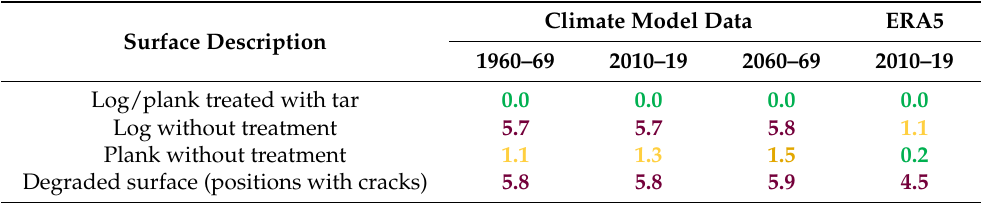
Table 6. Average values of annually maximum mold indices by taking into account all different substrate surfaces of the case studies, the atmospheric temperature, and the relative humidity under four different climatic